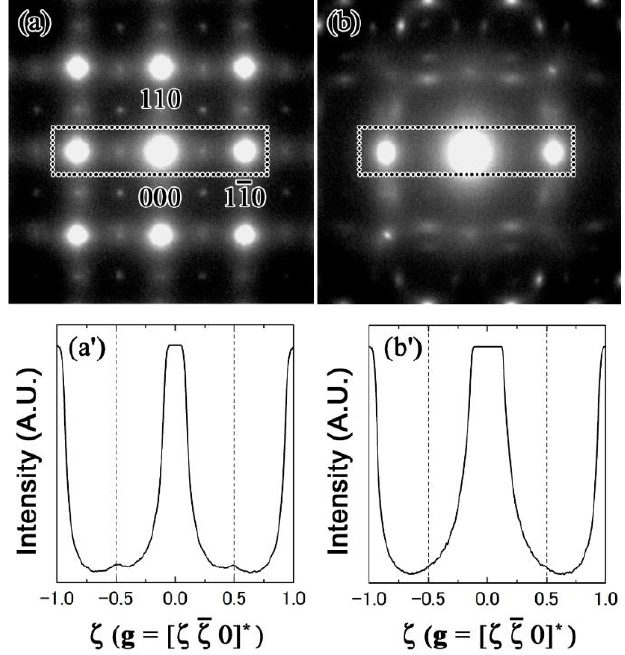
Figure 6. SADPs of the Zr-14 at.% Nb alloy: ( a ) SADP showing the zone axis of [001]; ( b ) SADP showing the systematic condition; ( a’ , b’ ) corresponding intensity profiles for the respective areas enclosed in the dotted boxes.